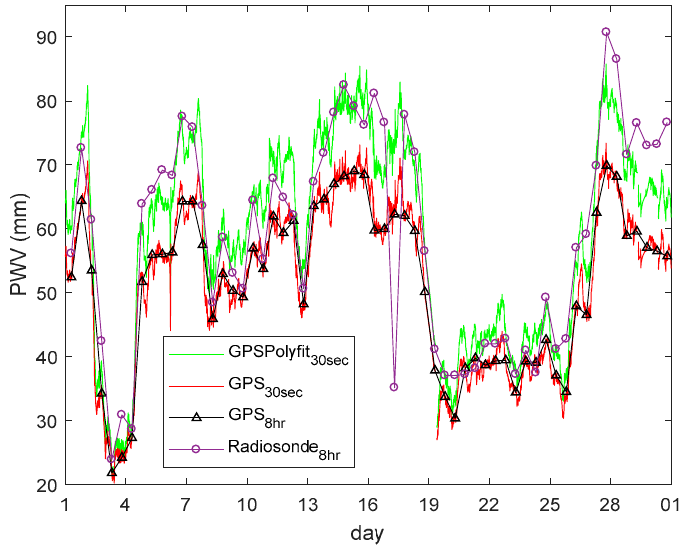
Figure 8. purple line with circle markers and black line with triangle markers represent the radiosonde and GPS PWVs, respectively, every 12 h; and PWV computed by the GPS (red line) and polynomial fit (green line) with a 30 s interval.